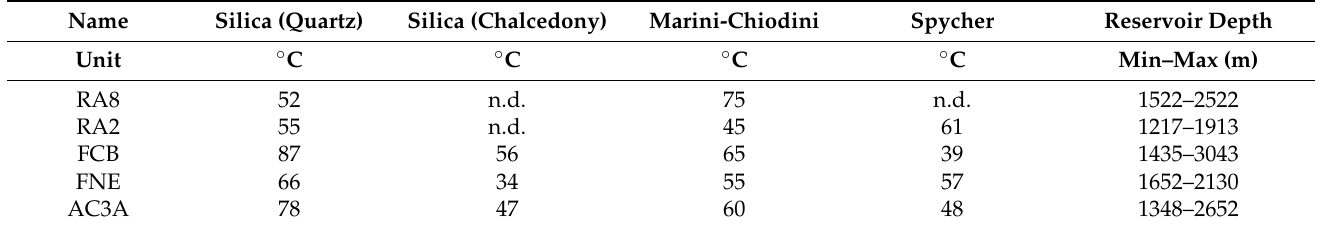
Table 4. Equilibrium temperatures, estimated by different geothermometers, and maximum and minimum reservoir depths for the water samples. n.d.—not determined or incongruent temperatures.